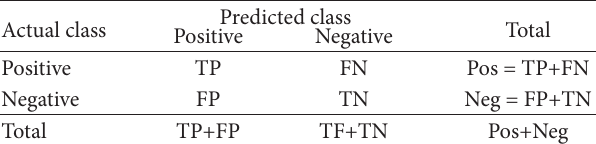
Table 1: Confusing matrix